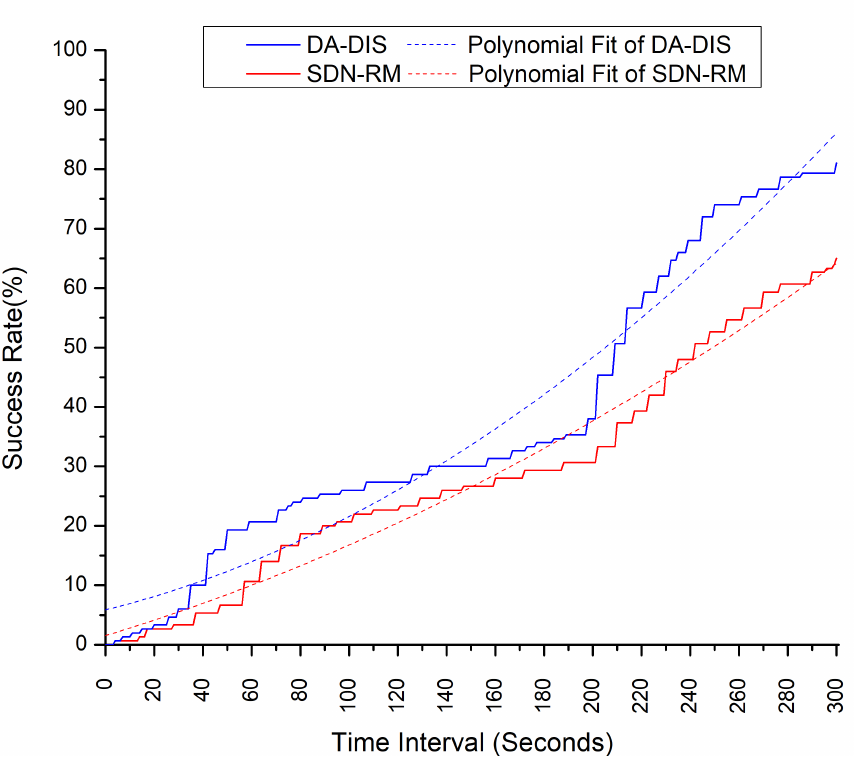
Figure 22. Effect of a malicious switch on the success rate during emulation.